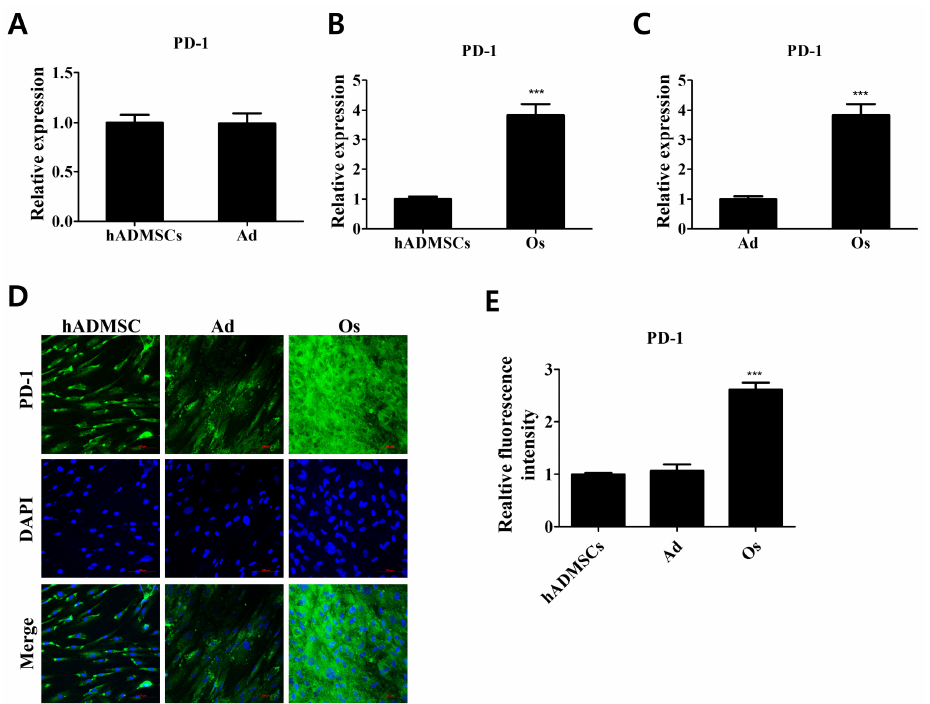
Figure 1. Relative PD-1 expression levels in differentiated cells derived from hADMSCs. ( A ) Relative mRNA expression level of PD-1 in adipocytes (Ad) and ( B ) osteoblasts (Os) compared with hADMSCs (human adipose-derived mesenchymal stem cells). ( C ) Variance in the expression level of PD-1 in differentiated cells. N = 3 trials per sample and control. ( D ) Cells were stained with PD-1 (green); DAPI was used to stain the nuclei (blue). ( E ) Relative fluorescence intensity of PD-1 receptor on cell surface of differentiated cells. N = 5 trials per sample and control. Data are presented as mean ± SEM. *** p < 0.001, compared with the hADMSCs and Ad group. hADMSCs: human adipose-derived mesenchymal stem cells; Ad: adipocytes; Os: osteoblasts.